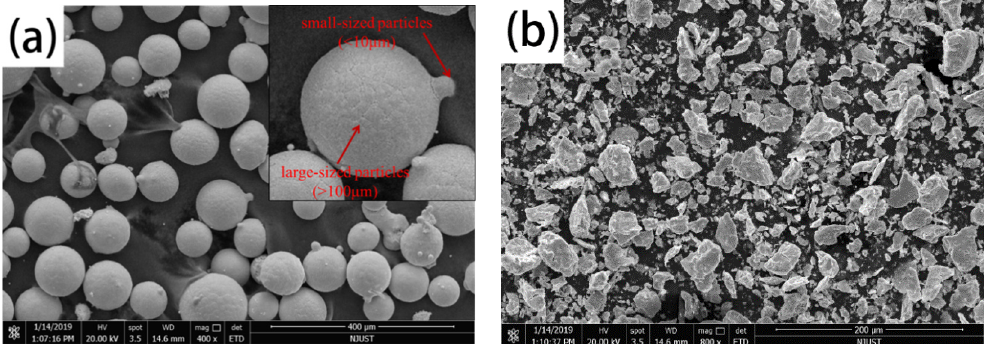
Figure 1. The shape of Ti-48Al-2Cr-8Nb pre-alloyed powder. ( a ) SP powder and ( b ) MP powder.